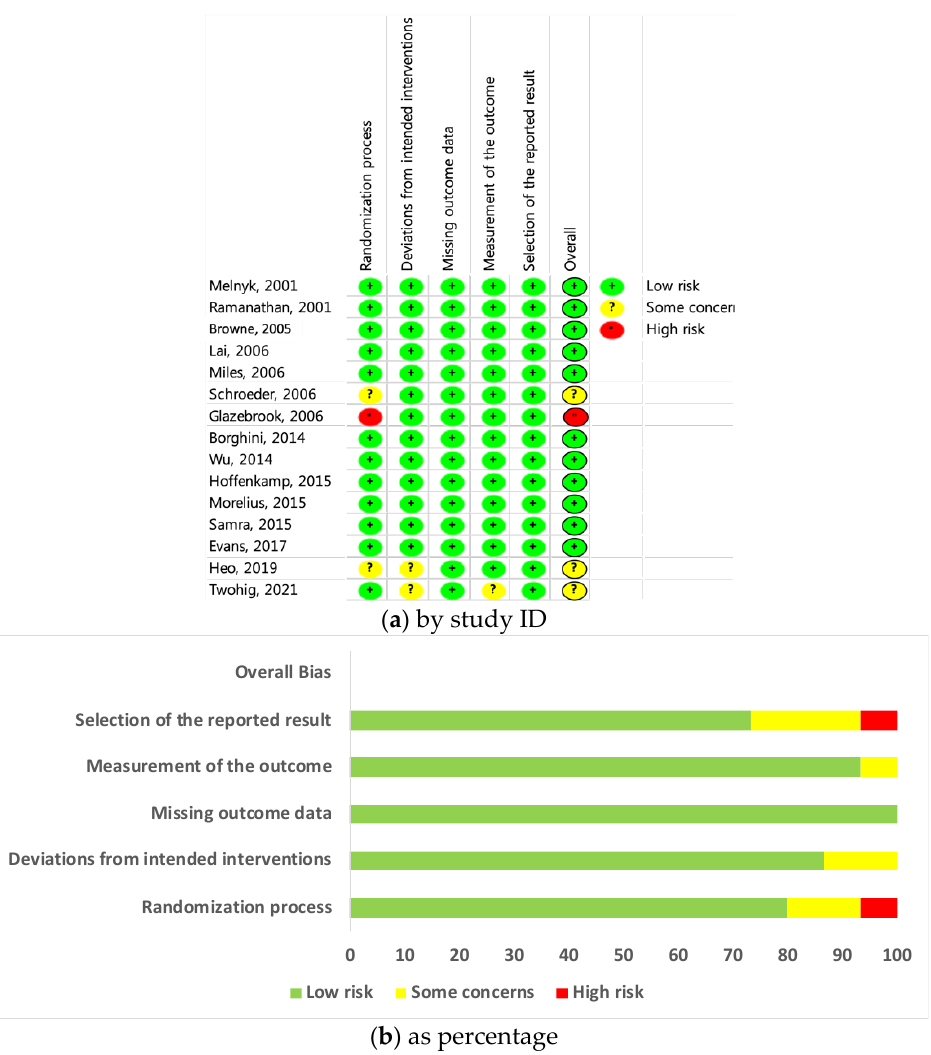
Figure 2. ( a ) Risk of bias assessment- by study ID; ( b ) Risk of bias assessment- by percentage.